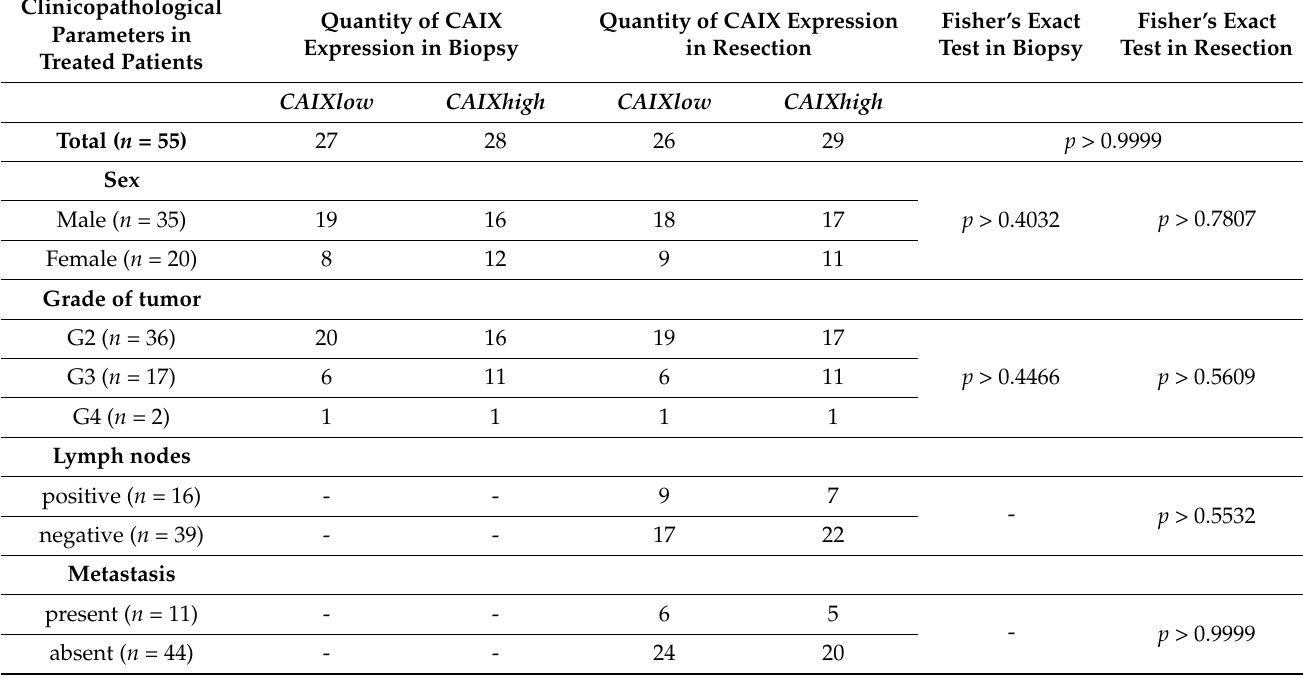
Table 1. Statistical distribution of CAIX expression concerning clinicopathological parameters of NAT rectal adenocarcinoma.